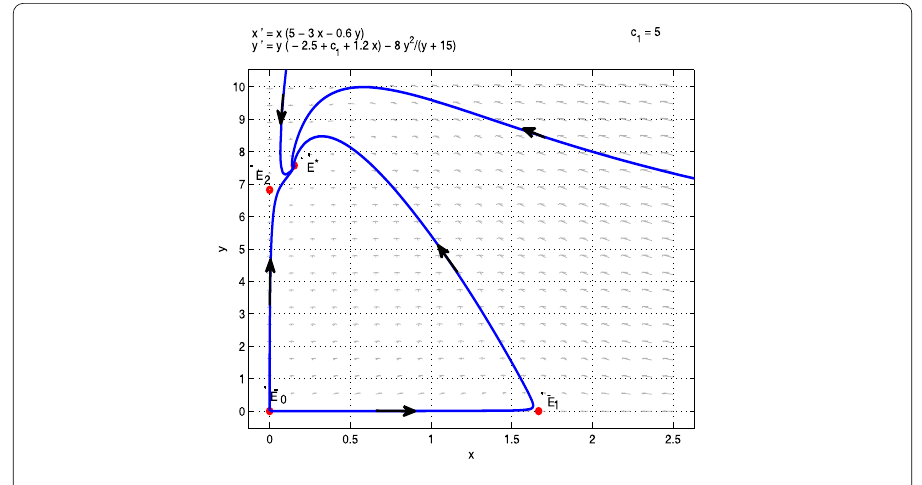
Figure 5 Dynamic behaviors of system (4.2) if c 1 = 5